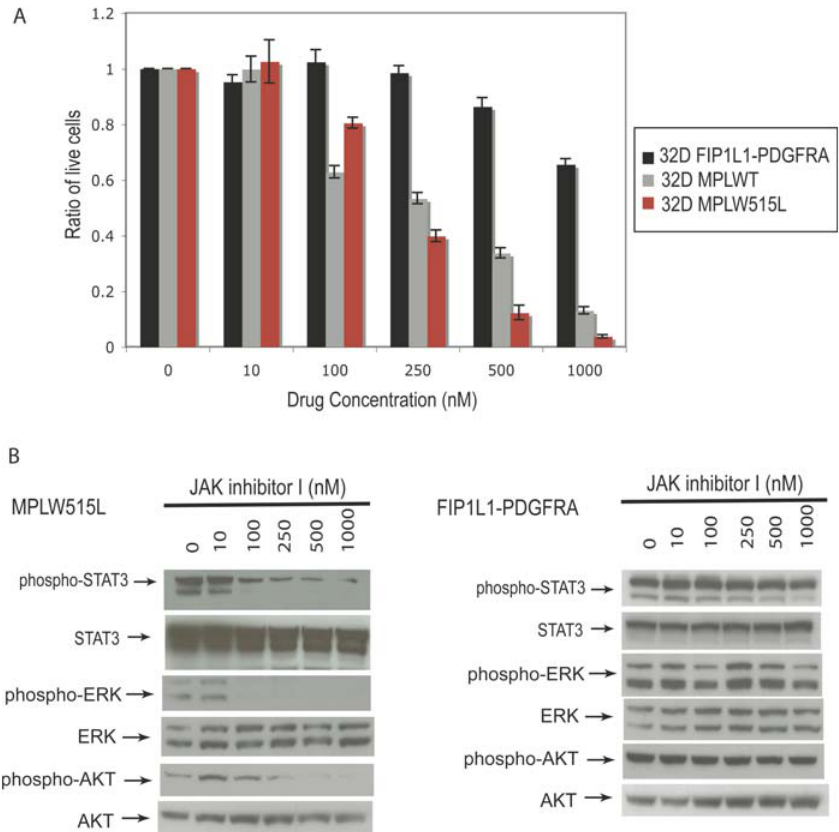
Figure 7. 32D MPLW515L Cells Are Sensitive to JAK Inhibitor I (A) Dose-dependent inhibition of growth of 32D MPLW515L and 32D MPLWT cells but not 32D FIP1L1-PDGFRA cells with increasing doses of JAK Inhibitor I. (B) Reduction in STAT3 phosphorylation in 32D MPLW515L cells but not 32D FIP1L1-PDGFRA cells with increasing doses of JAK Inhibitor I. Cells were incubated with varying drug concentrations for four hours and then collected for Western blot analysis. DOI: